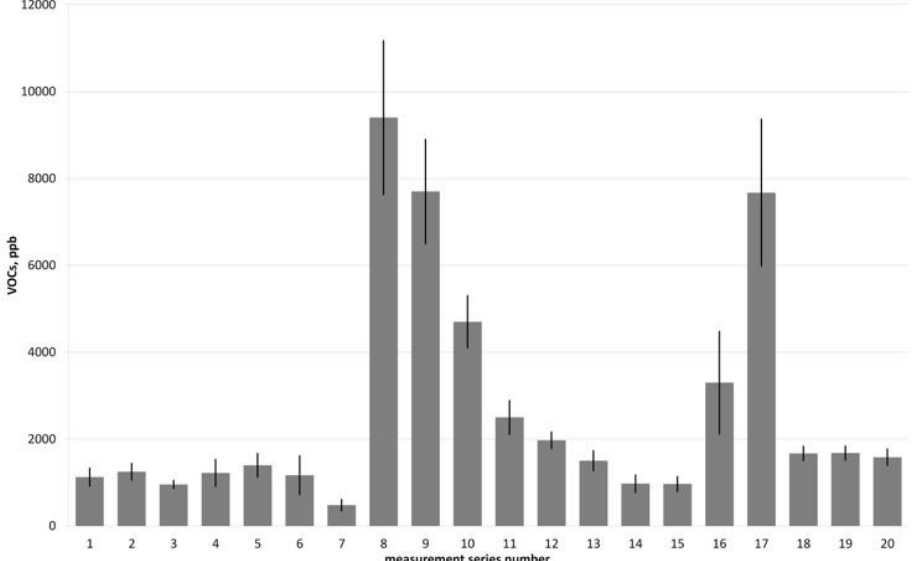
Figure 4. Fluctuations of volatile organic compound (VOC) concentrations in the analyzed raw food industry gases throughout the research cycle. Results for each measurement series are represented by the arithmetic average.